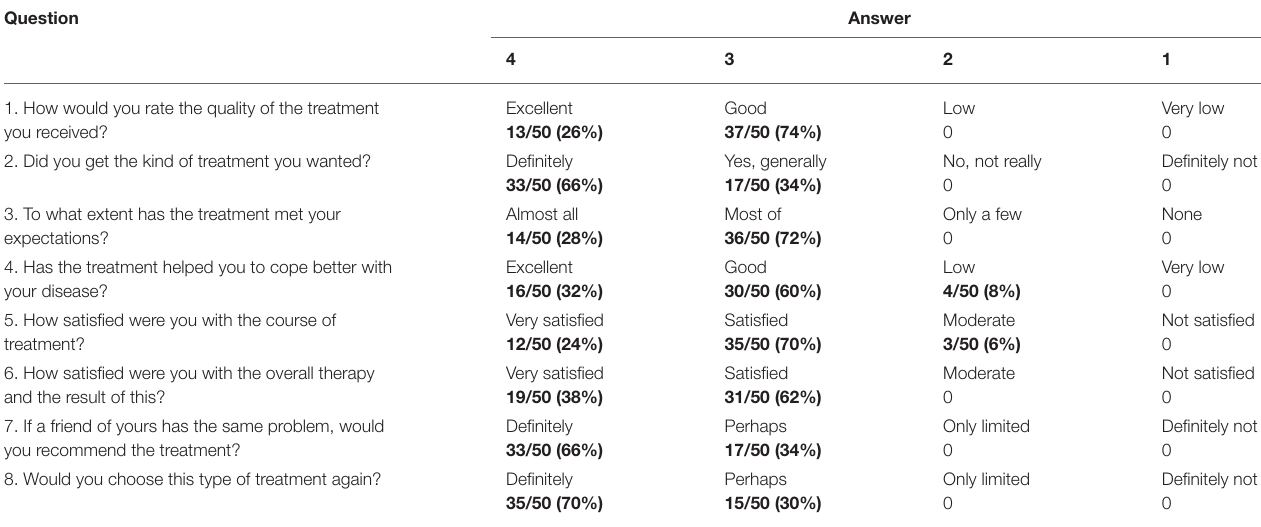
TABLE 4 | Evaluation of general patient satisfaction using the CSQ-8 questionnaire. Question